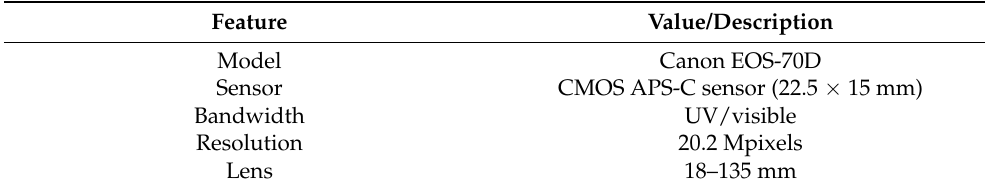
Table 1. Specifications of the DSLR